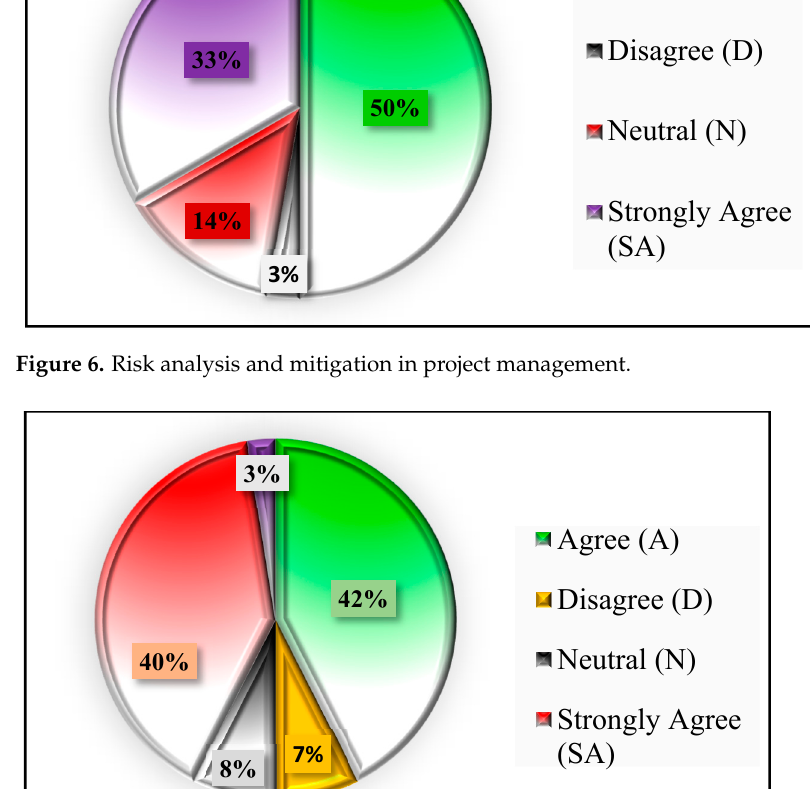
Figure 7. Vision and clarity in project management .